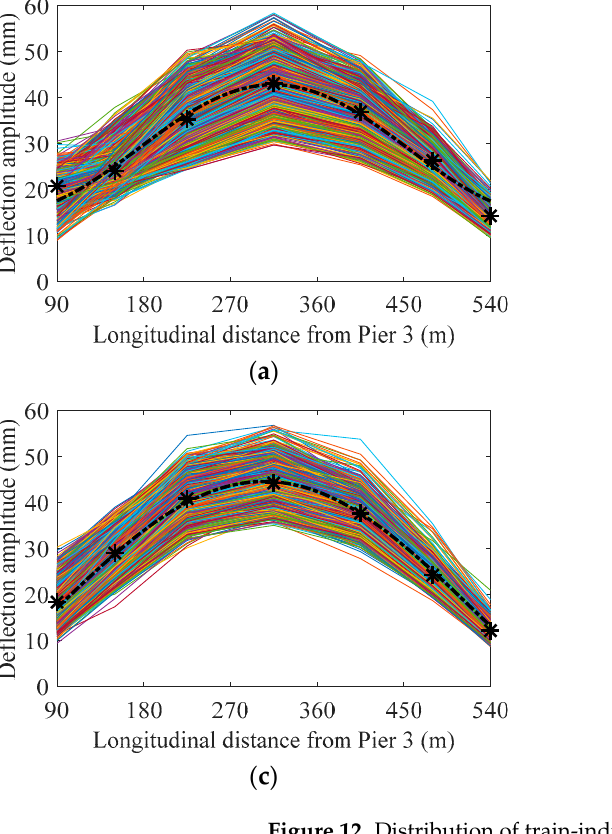
Figure 12. Distribution of train-induced deflection amplitude in each traversing of trains: ( a ) outside track and 8 carriages; ( b ) outside track and 16 carriages; ( c ) inner track and 8 carriages; ( d ) inner track and 16 carriages.